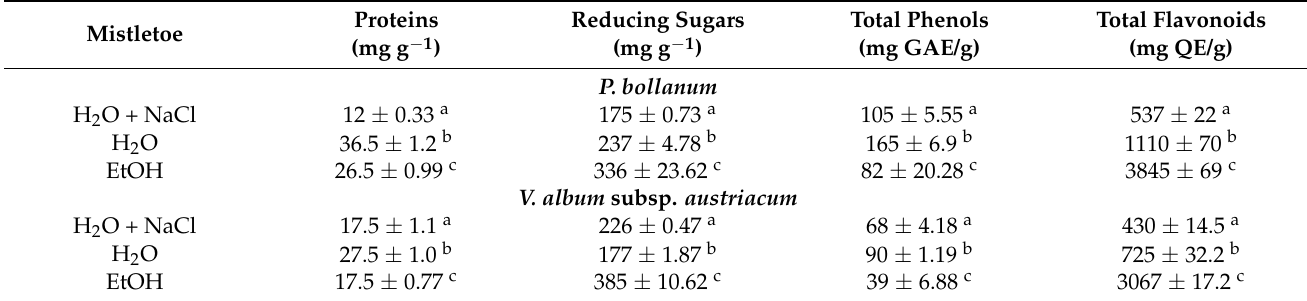
Table 3. Concentrations of biochemical components of P. bollanum and V. album subsp. austriacum in extracts obtained with different solvents (standard deviations are